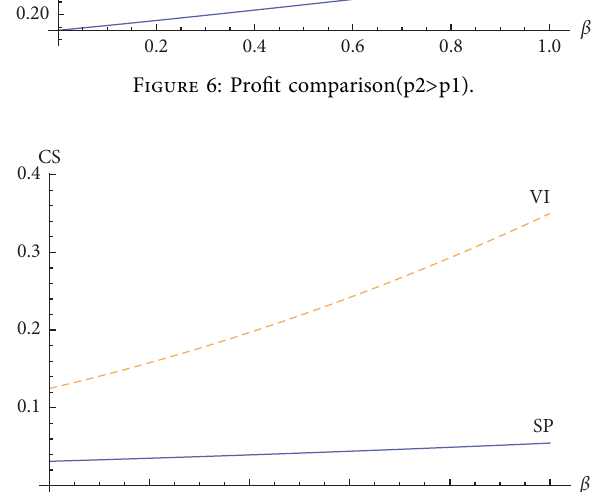
Figure 7: Consumer surplus comparison(p2 >